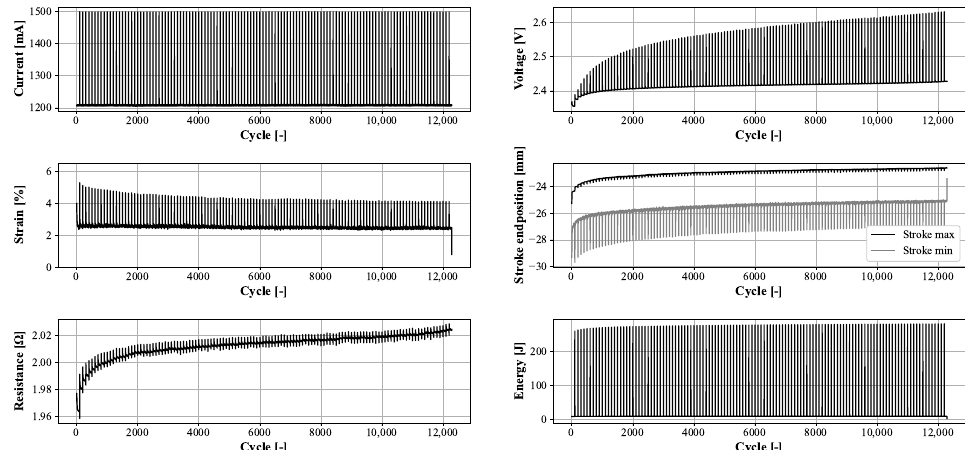
Figure 3. Maximum of current, voltage, strain, energy and resistance per cycle for a 3% strain. Every 100th cycle was a full activation (5% strain) to further track the degradation of the parameters.